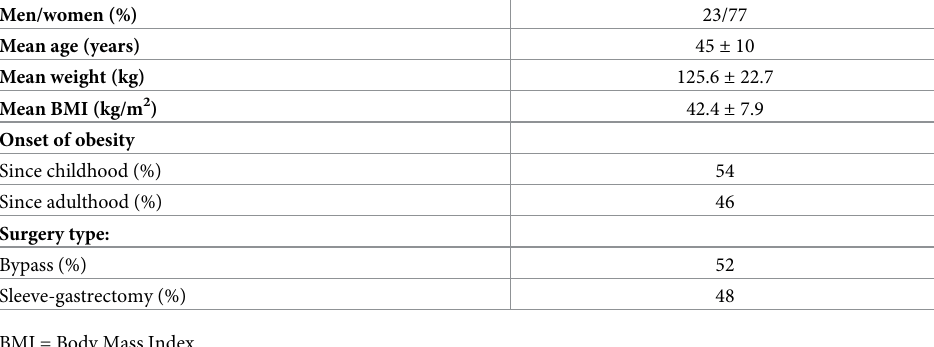
Table 1. Characteristics of the bariatric surgery candidates at the preoperative assessment. Quantitative variables are expressed as the mean ±